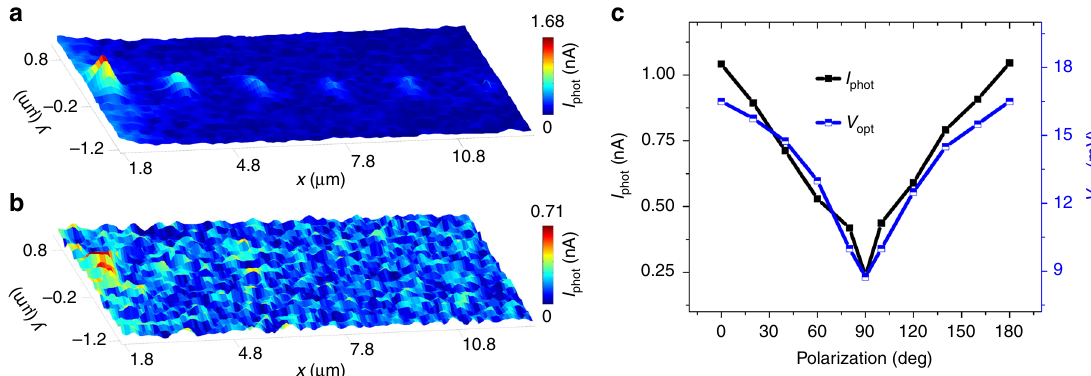
Fig. 2 Polarization response of the optical link. a Photocurrent map generated by the rectenna reconstructed pixel-by-pixel by scanning the optical antennas through the laser focus. The scanned region is indicated by the black dotted rectangle in Fig. 1b. The incident polarization is along the vertical direction, y -axis (0°) for excitation intensity 353kWcm − 2 . b The same region for an incident polarization along the horizontal direction, x -axis (90°). V dc is constant at 50 mV. c Plot of I phot and V opt as a function of incident polarization for individual excitation of an antenna which is 4 μ m away for an excitation laser intensity of 540kWcm − 2